Question: Briefly state, in one sentence, what is plotted here.
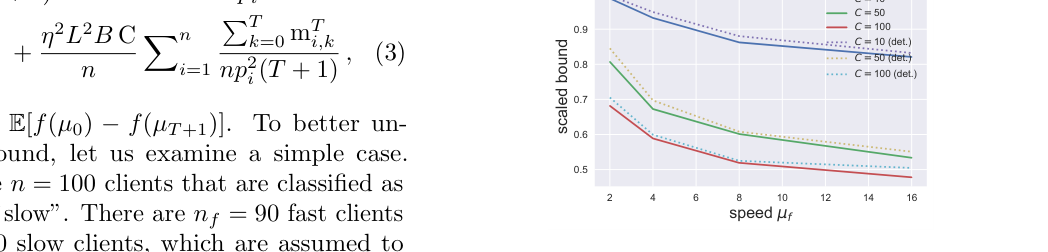
Answer: Relative improvements of the upper bounds as a function of the speed for different concurrency levels. The number of nodes is fixed to n = 100 nodes.